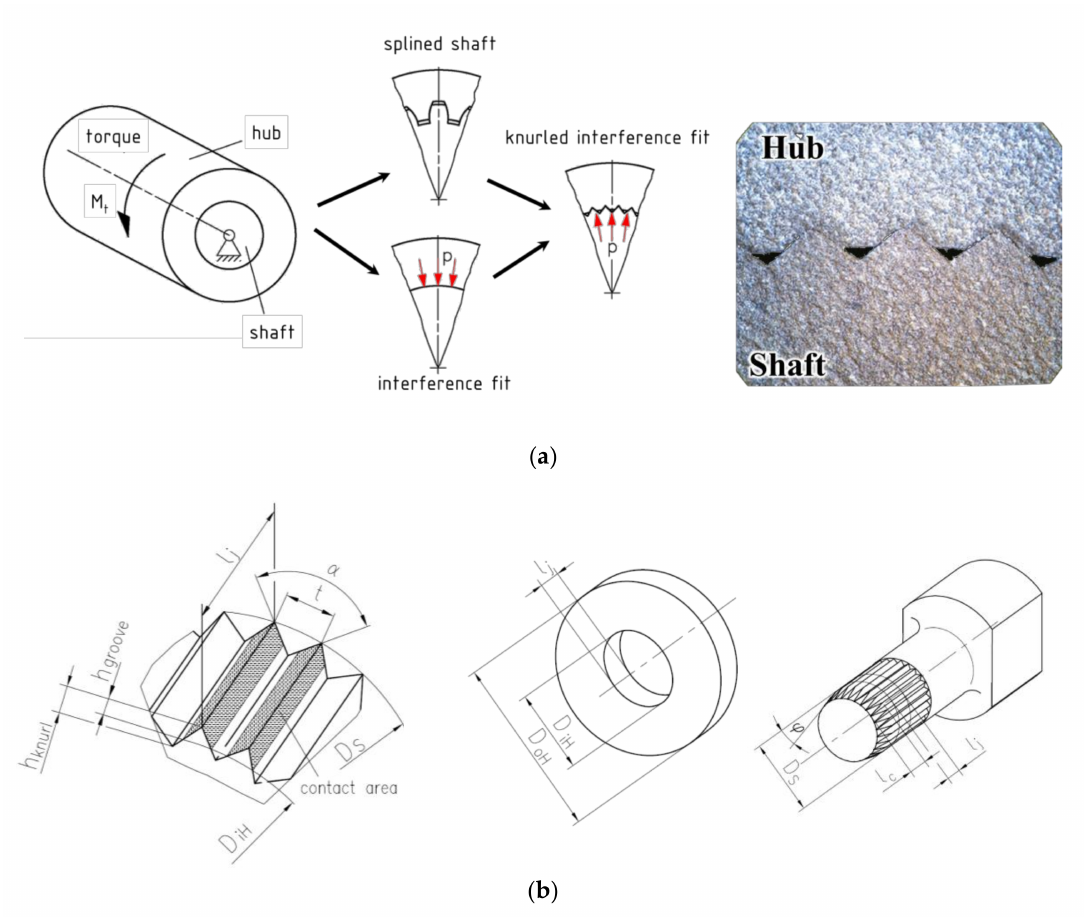
Figure 1. ( a ) Fusing of principles for torque transmission; and ( b ) geometry of knurled interference fit according to